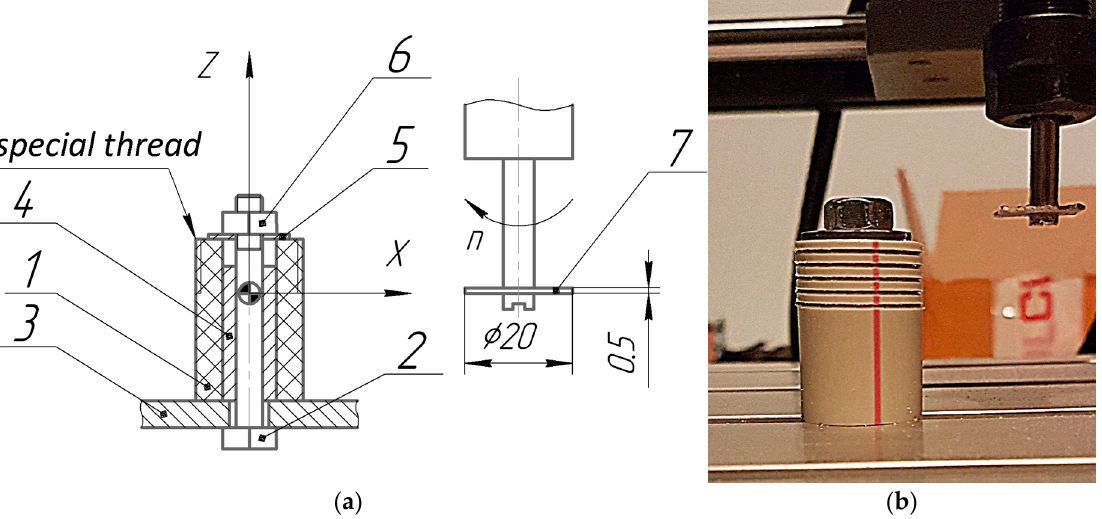
Figure 8. Technological sketch ( a ) and photograph ( b ) of milling a special thread on a CNC 3018 Pro machine.